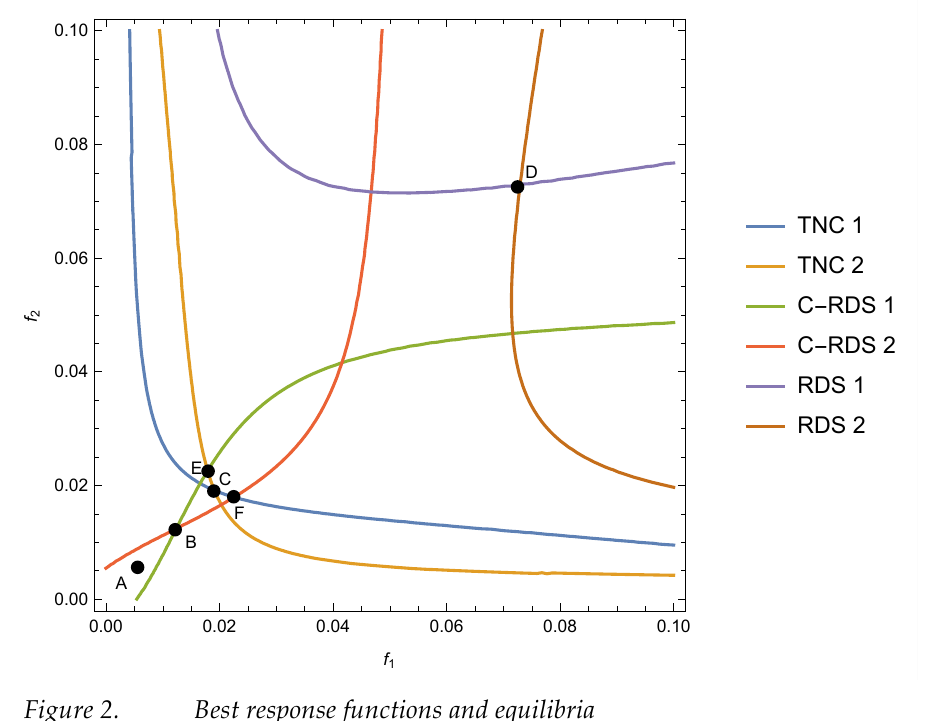
Figure 2. Best response functions and equilibria Parameter values are: α = 1.4, β = 0.02, δ = 1, c = 0.265, K c = 0.05, w = 2 and K r = 0.05